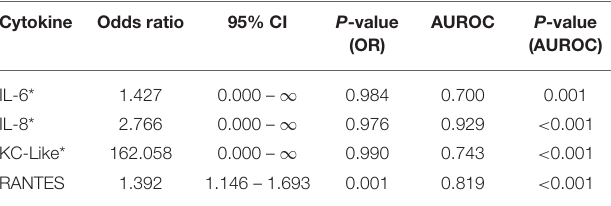
TABLE 3 | Odds ratios for the differentiation of sick cats (i.e., those with sepsis or septic shock) from healthy controls based on measured cytokine concentrations. Cytokine Odds ratio